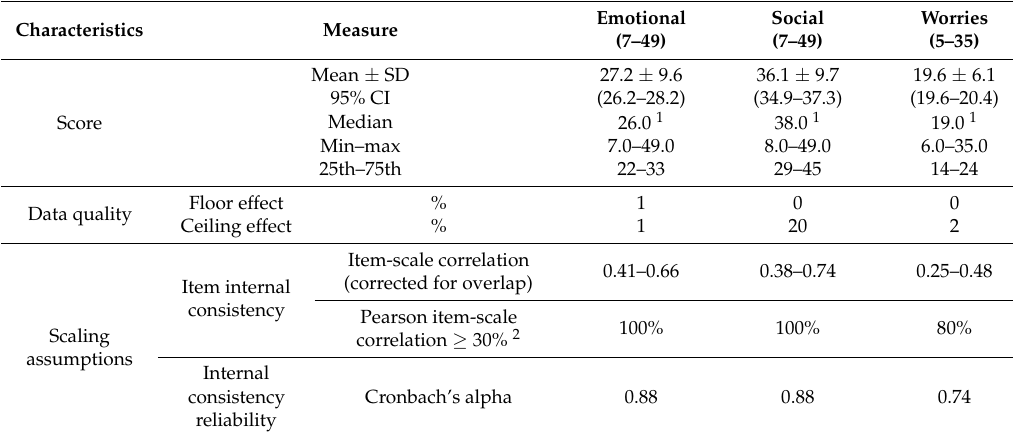
Table 2. Descriptive statistics for the